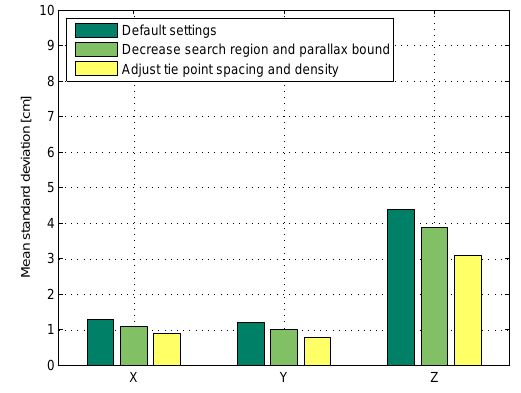
Figure 10: Mean standard deviations of tie points in object space regarding three different bundle block adjustments. The matching strategies are different in each